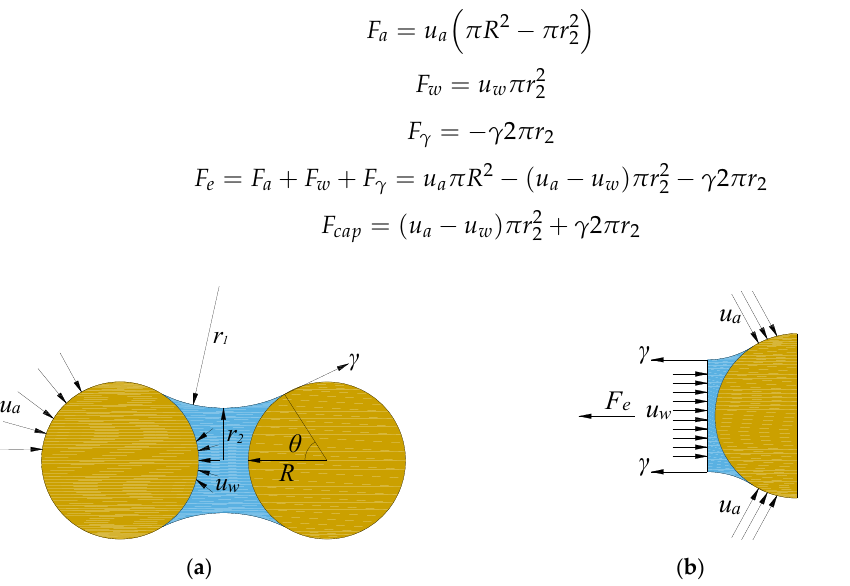
Figure 12. Gas–liquid–solid interaction mode between two particles and meniscus:( a ) sketch of interaction between two sand particles and meniscus; ( b ) illustration of inter-particle forces.